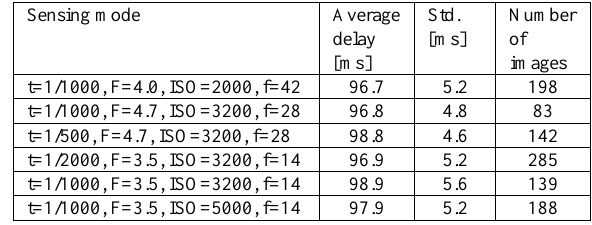
Figure 10. Calibration field with detail of radiant point . Root mean square of residuals after calibration is 0.16 pixel and maximum residual is 0.59 pixel. These values indicate the quality of achieved results.